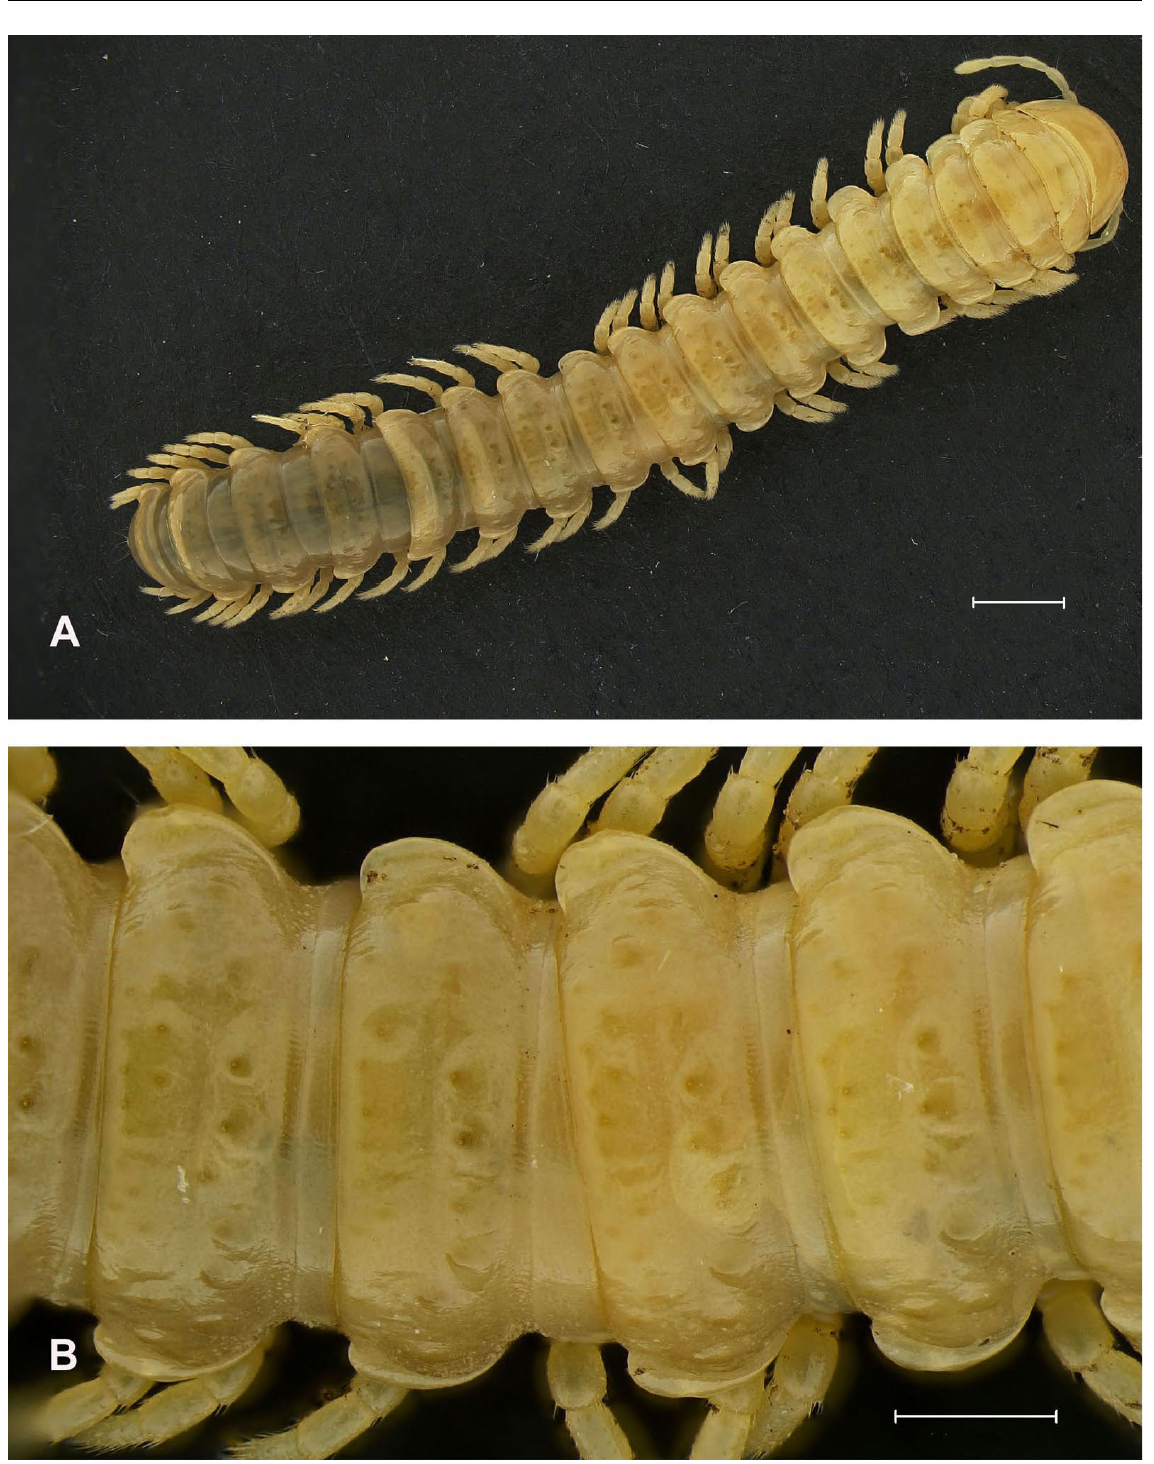
Fig. 1. Levizonus circularis Takakuwa, 1942, ♂, from Russia (FSCB 142005). A . Habitus, dorsal view. B . Midbody rings, dorsal view. Scale bars: A = 2 mm; B = 1